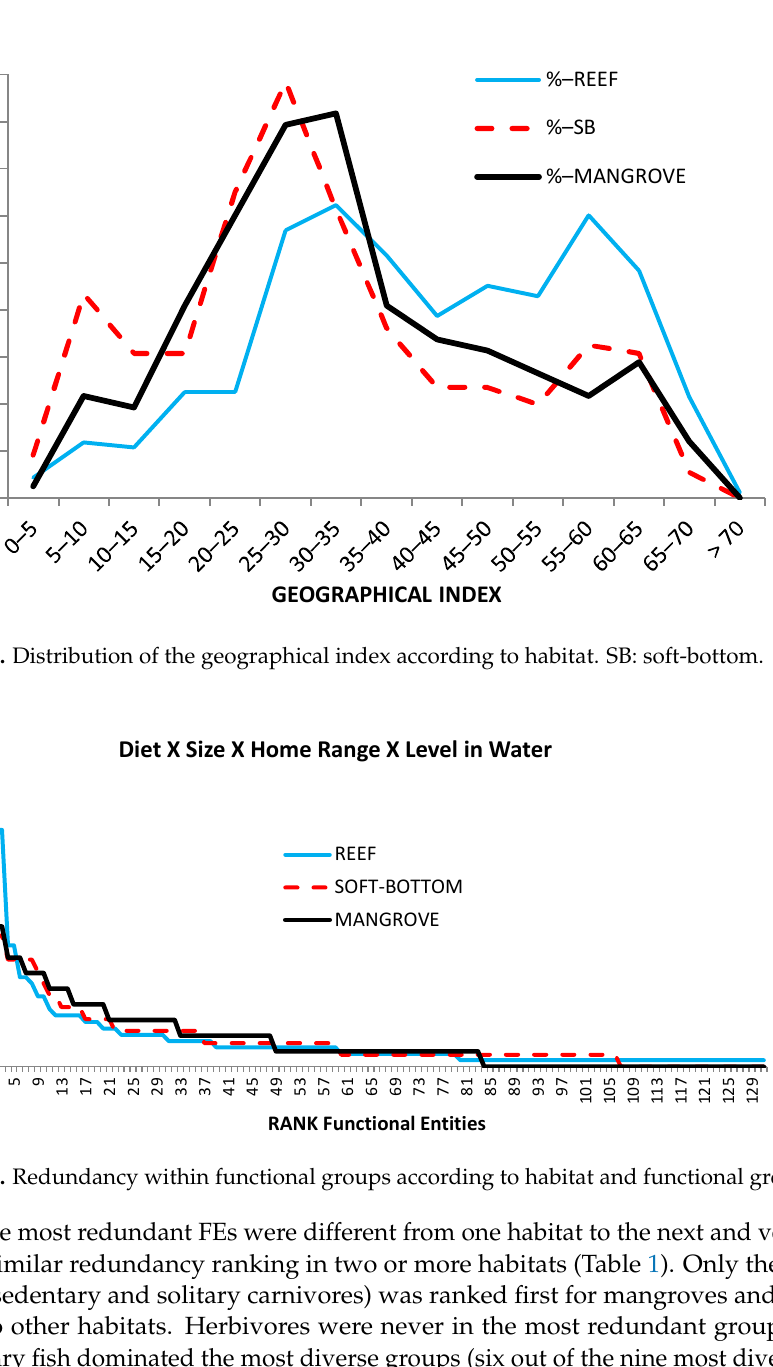
Figure 7. Redundancy within functional groups according to habitat and functional group type.